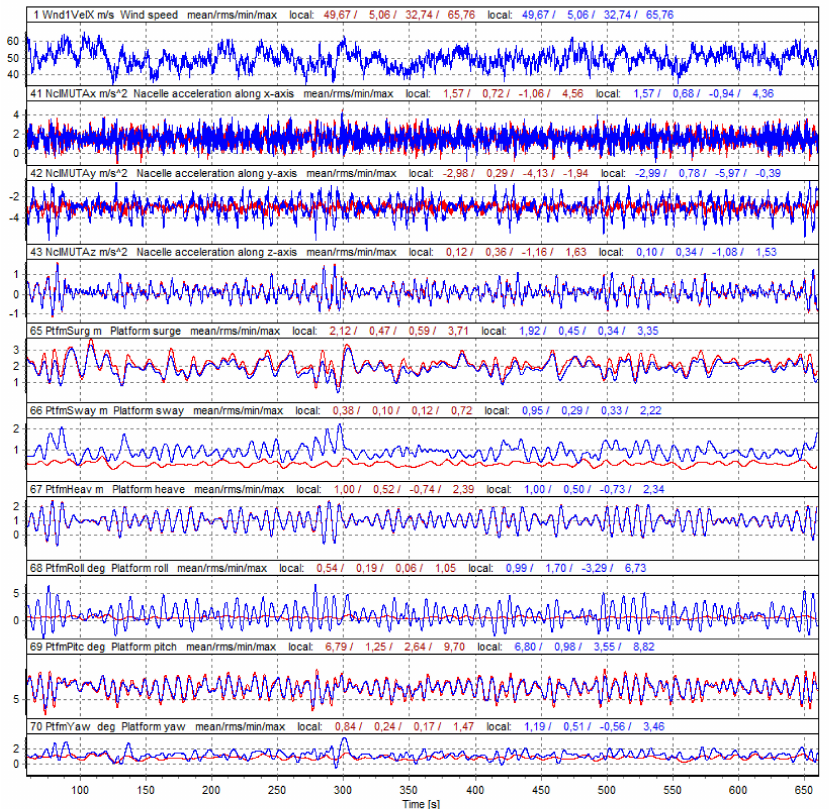
Figure 13. Time history of platform motions and nacelle acceleration from simulation without current loads (shown in red) and simulation with current loads (shown in